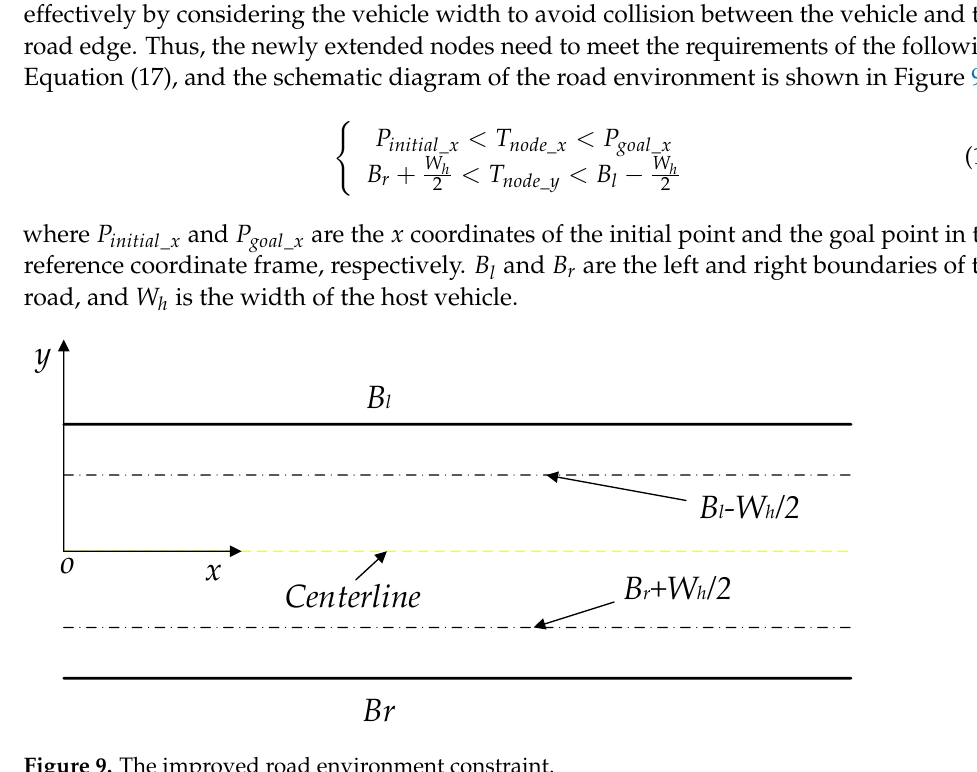
Figure 9. The improved road environment constraint.